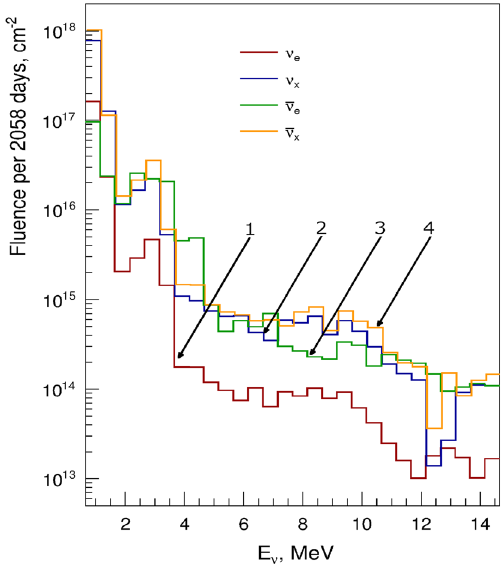
Fig. 5 Upper limits on the fluences of monoenergetic ν e ,μ,τ and ¯ ν e ,μ,τ obtainedfromthespectralfit(90%C.L.):1– ν e ,2– ν μ,τ ,3– ¯ ν e ,4– ¯ ν μ,τ